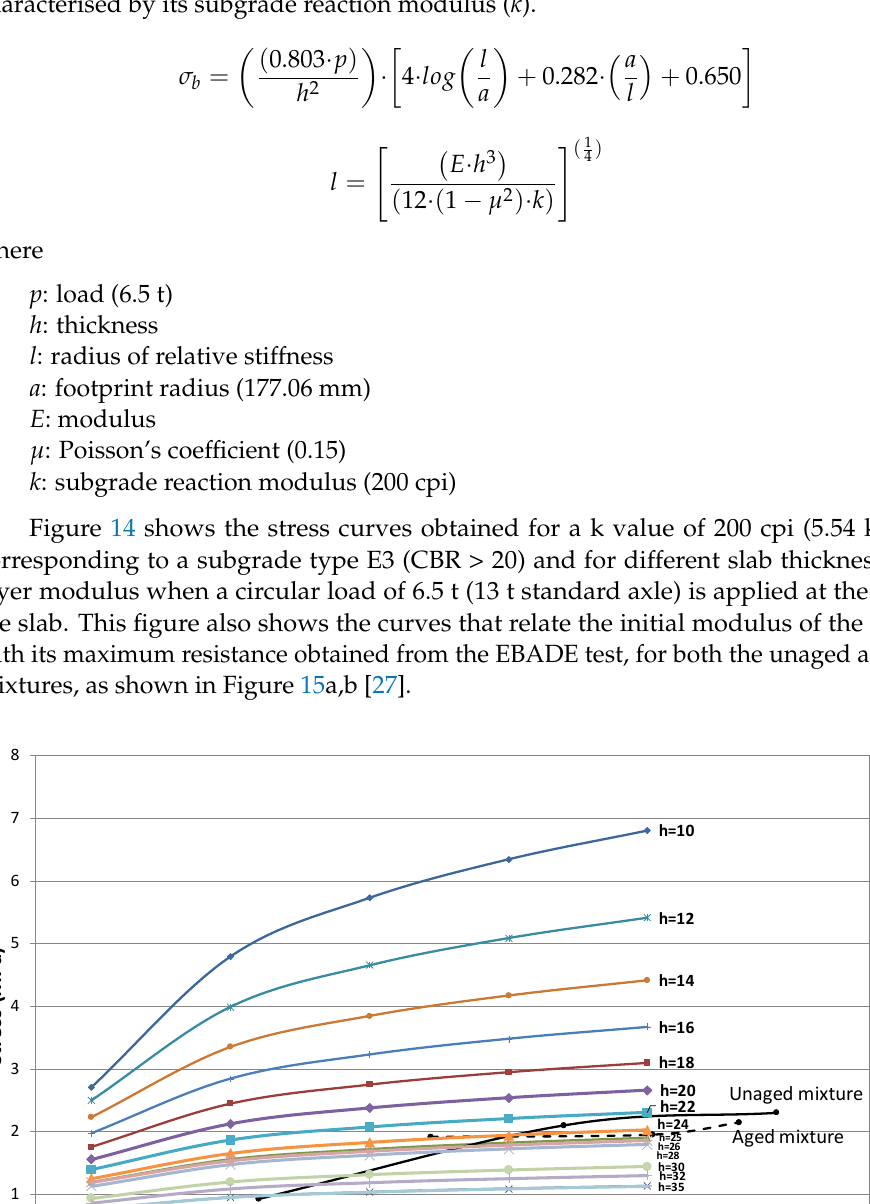
( b ) Figure 15. ( a ) Stress evolution for unaged mixtures and ( b ) Stress evolution for aged mixtures, at different test temperatures. Figure 14 demonstrates that the stresses that could occur in these slabs would exceed the resistance of the bituminous mixture for thicknesses less than 24–25 cm. This 25 cm thickness, which was used in the construction of the sections for the traffic category be- tween 4·10 6 and 10 7 13-ton axle load applications, in the first issue of the Spanish Catalogue of Structural Sections, would probably lead to the breakage of the slabs and to the total ruin of the pavement. These calculations support the decision taken to increase the thick- ness of the bituminous layers by 5 cm. Often, when these cracks arrive at the interface of the bituminous layers, they will propagate through the interface, leaving the upper layers detached. These thinner layers break first. One of the most usual maintenance operations is indeed the milling and re- placement of these layers. The aforementioned extra thickness added to the pavement may be necessary to safeguard the structural capacity of the pavement, when this damage occurs and the layers are repaired. Considering this damage mechanism, the proposed calculation procedure could be a new tool that could help when applying the analytical methods to the dimensioning of the pavements.